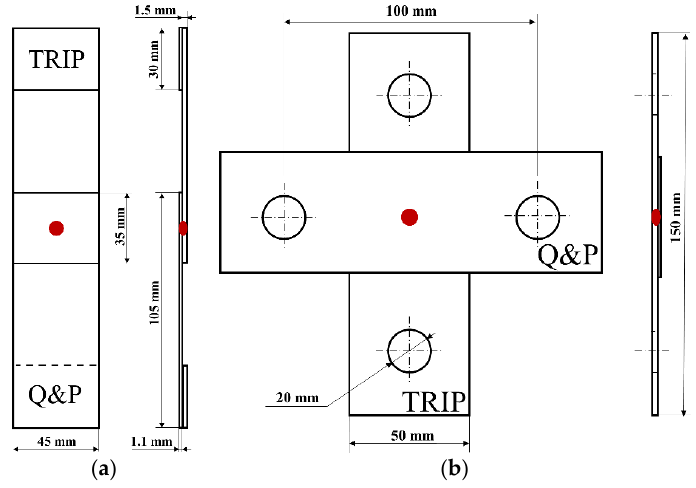
Figure 2. Geometrical size of the welded ( a ) shear tension and ( b ) cross tension specimens. Drawings not to scale.